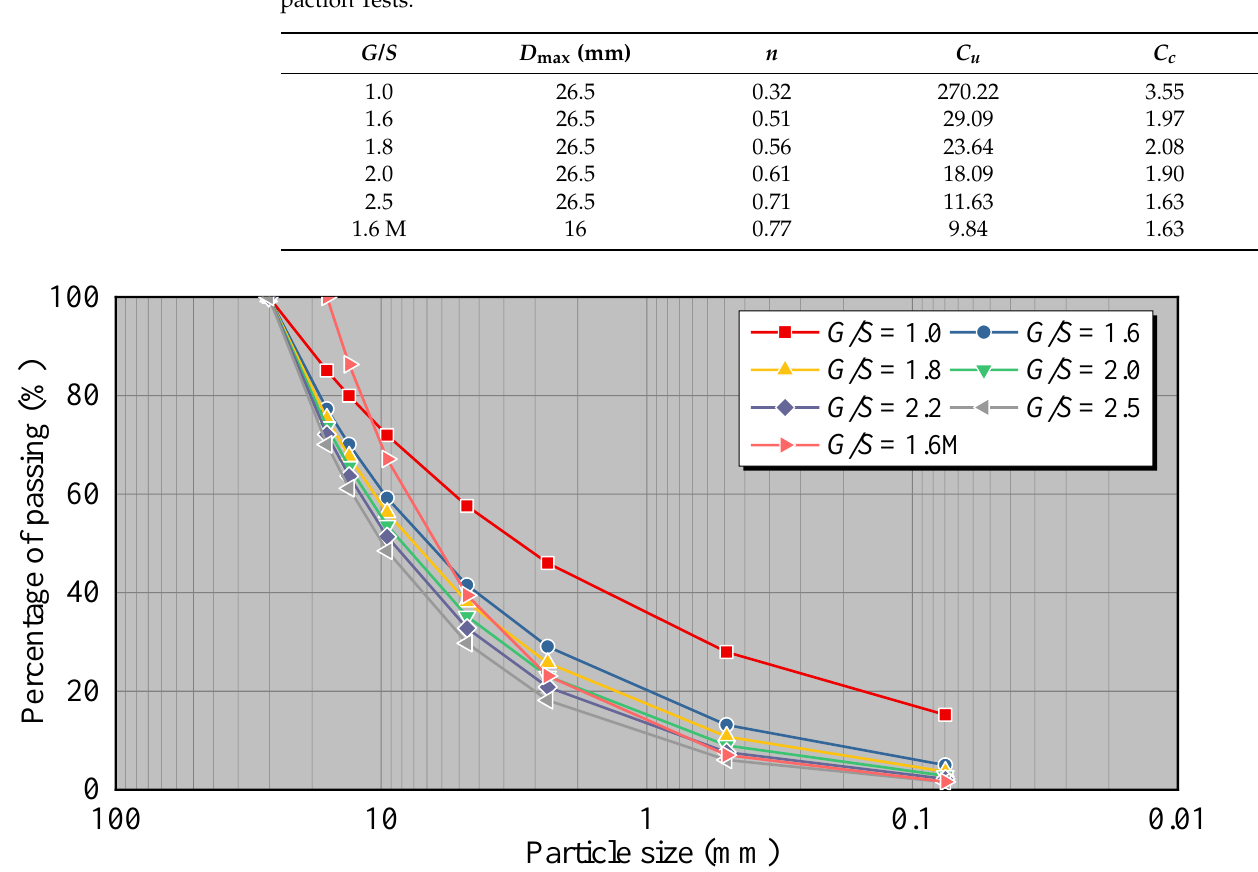
Figure 2. Gradation Curves of UPAB Specimens Used for Laboratory Compaction Tests.